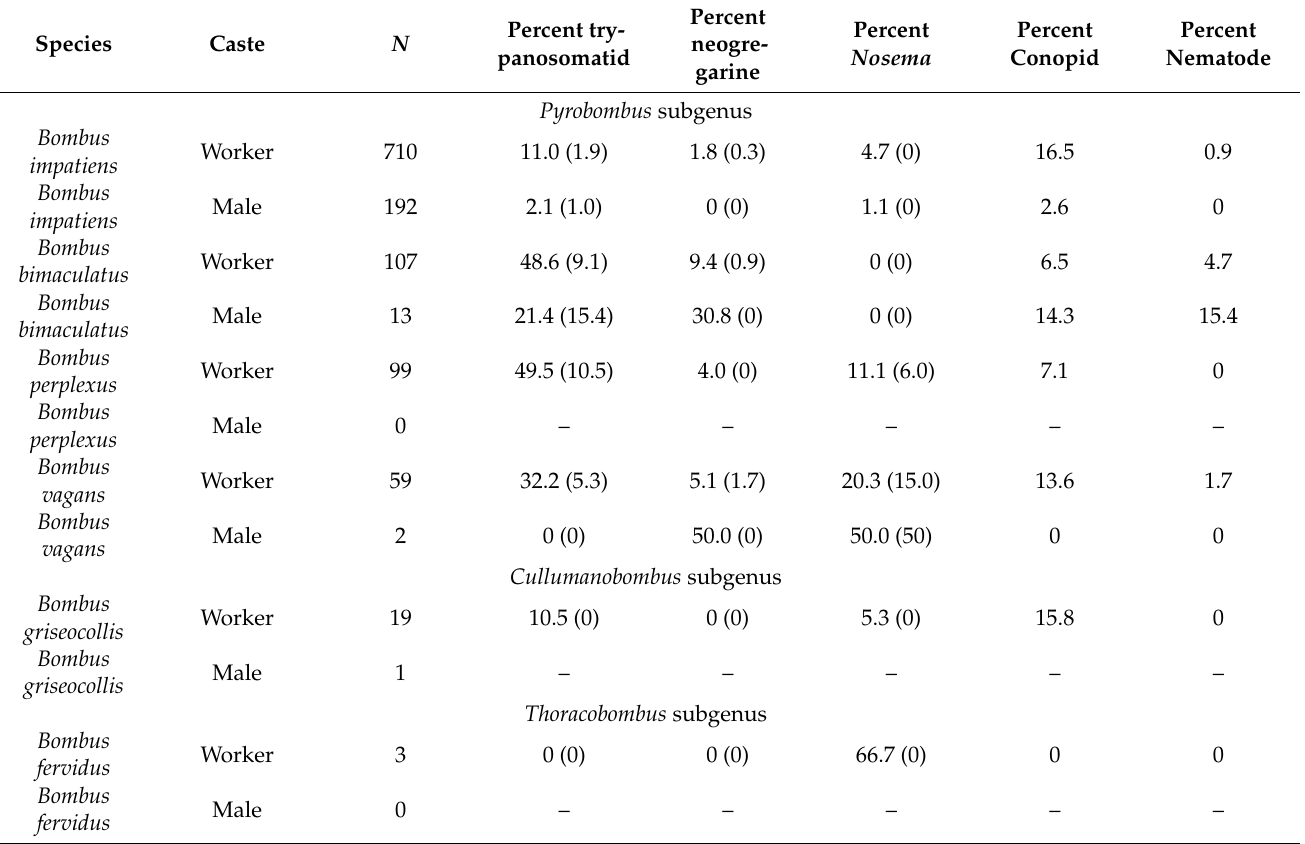
Table 2. For each species, the numbers of workers and males collected (caste) during our surveys, including the percent of individuals infected with parasites. The prevalence of intense infections is shown in